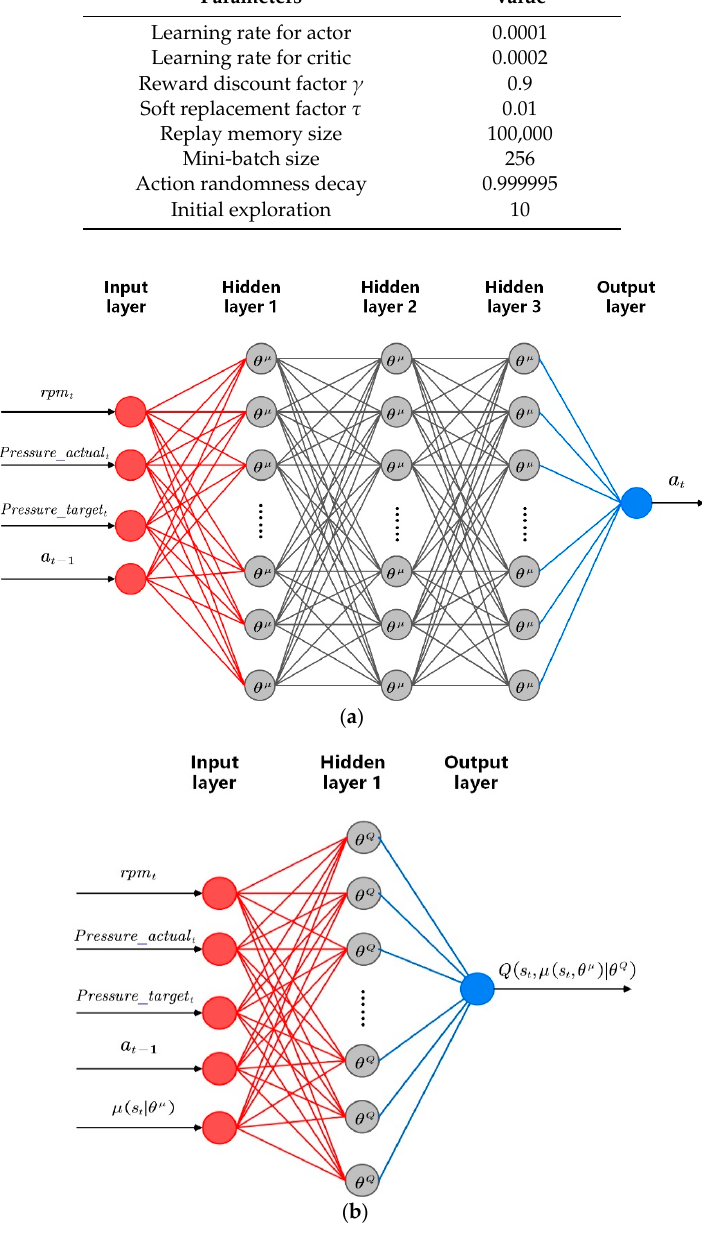
Figure 11. Illustration of the ( a ) actor network and ( b ) critic network.